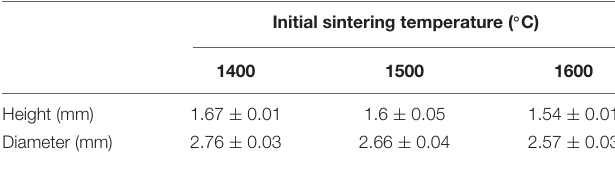
models of the YSZ oxide pellets containing a lumped Gd 2 O 3 sphere or mini-pellet were heated from 25 ◦ C to 1500 ◦ C or 1600 ◦ C for the case of YSZ or UO ◦ C/min, 2 with a heating rate of 10 in accordance with the experimental